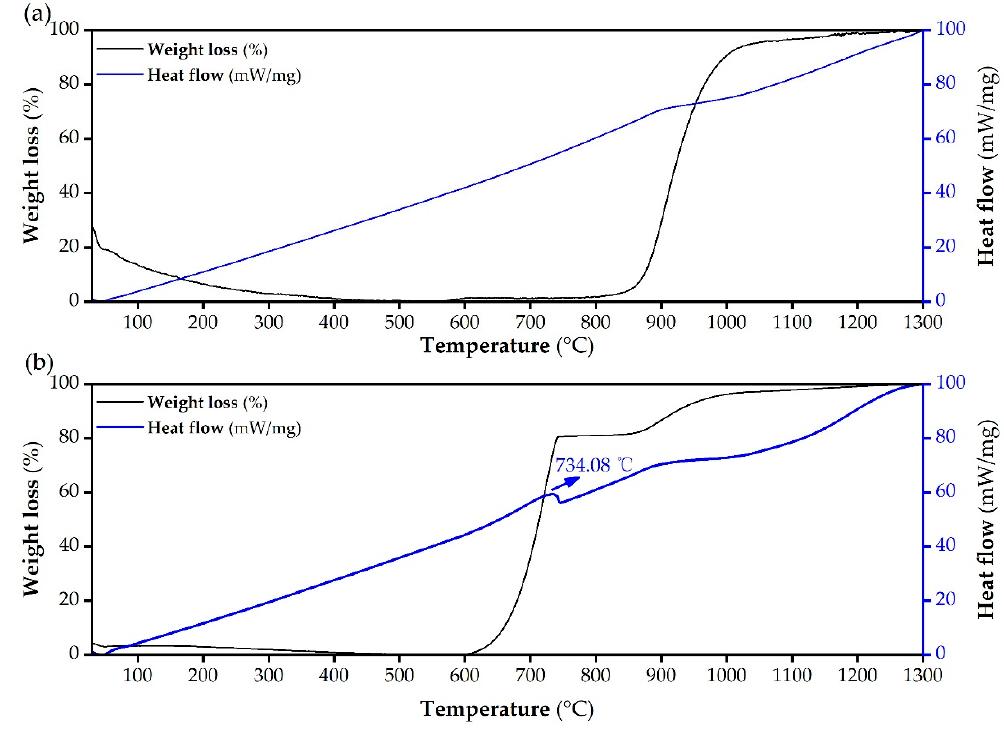
Figure 7. TG-DSC curves of ( a ) talc powder and ( b ) the mixture of talc powder and CaCO 3 .